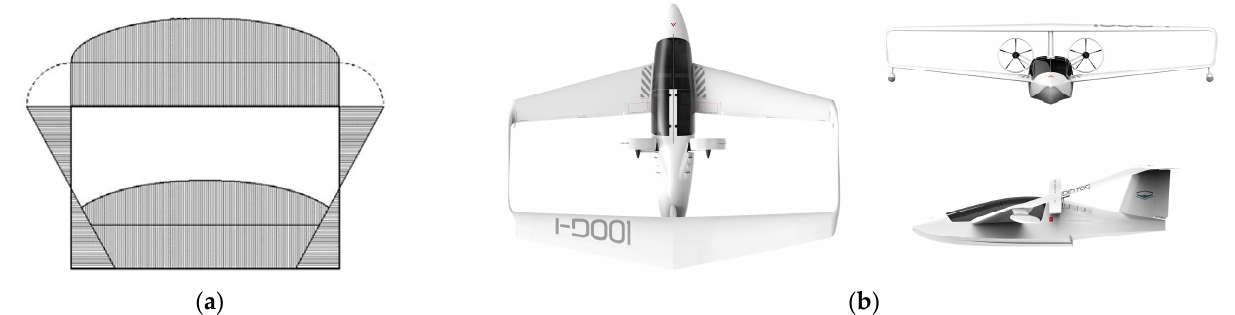
Figure 4. Example of box-wing architecture: ( a ) Lift distribution of the “best wing system” [62]; ( b ) Views of the 2-seater amphibious PrandtlPlane “IDINTOS” [64,65].